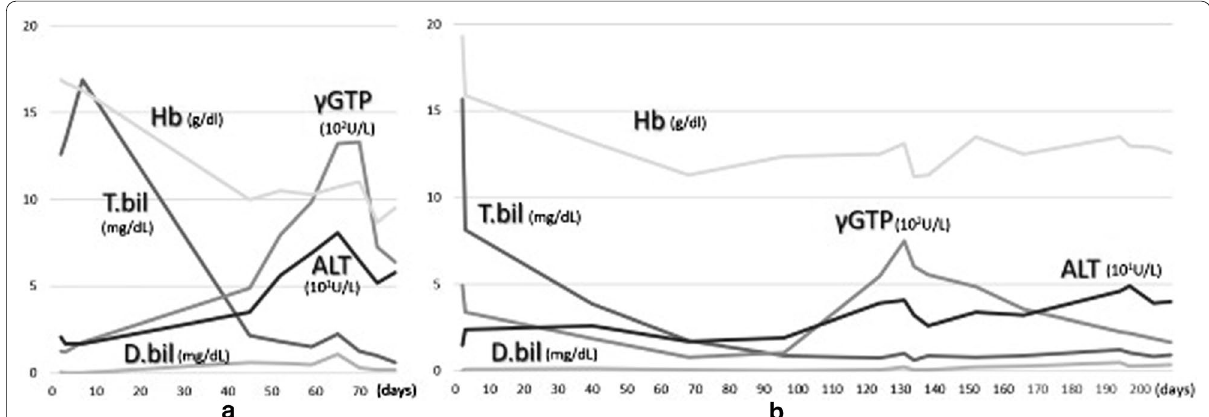
Fig. 2 Laboratory data. a Preoperative laboratory data of Case 1. The transaminase and gamma-glutamyl transpeptidase (γGTP) concentration were elevated, but the direct bilirubin concentration was not significantly increased. b Preoperative laboratory data of Case 2. The hemoglobin level gradually decreased but the transaminase and γGTP concentrations did not increase during the neonatal period. However, the serum levels of transaminases and γGTP began to gradually increase at 4